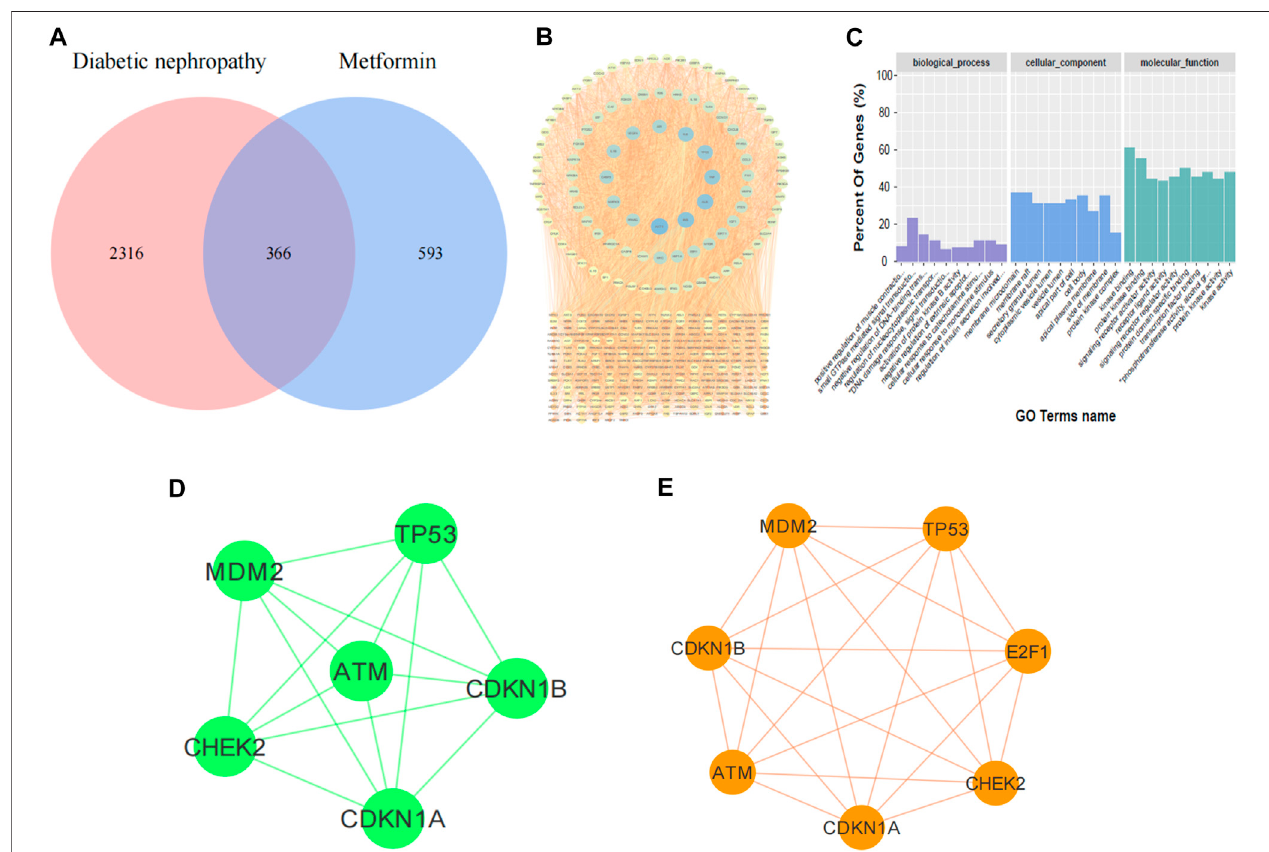
FIGURE 1 | Results of network pharmacology prediction. (A) Venn diagram of DKD - metformin target intersection. (B) PPI diagram of intersection protein. (C) Diagram ofGOenrichmentanalysis. (D) PPI diagram ofmetformintreatmentagainstDKDby regulating DNAdamage. (E) PPI diagram ofE2F1 involvedin DNA damage in DKD treated with metformin.